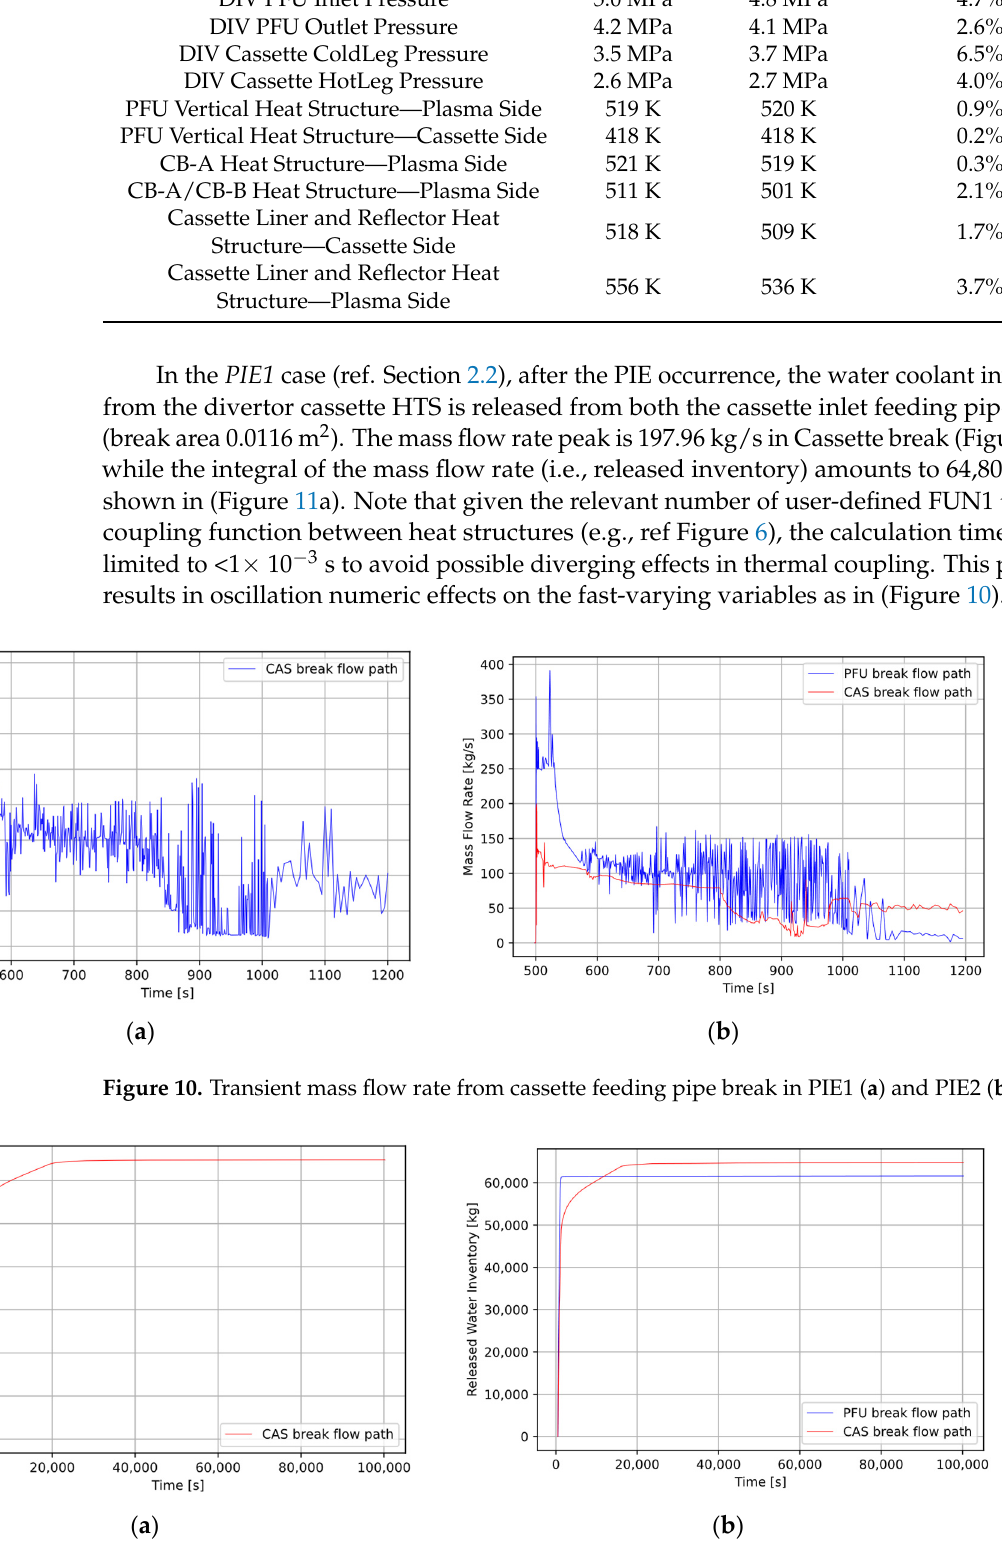
Figure 11. Released inventory from break in PIE1 ( a ) and PIE2 ( b ) cases. In the PIE2 case (ref. Section 2.2), after the PIE occurrence, the water coolant is released from both the cassette and PFU inlet feeding pipe, respectively FL121 (break area 0.0116 m 2 ) and FL101 (break area 0.0286 m 2 ), and at the inlet of one cassette unit chosen as the break point. Due to a higher pressure (5 MPa vs. 3.5 MPa) and a bigger feeding pipe size (DN125 vs DN80) in the PFU HTS loop with respect to the CAS HTS loop, a higher